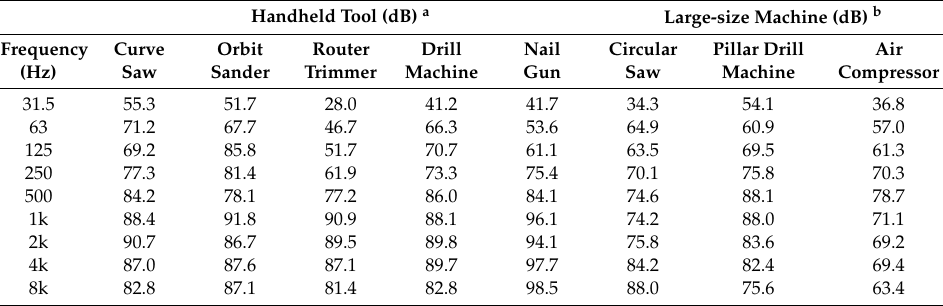
Table 2. Frequency spectra (1 / 1 octave) measured from power tools in